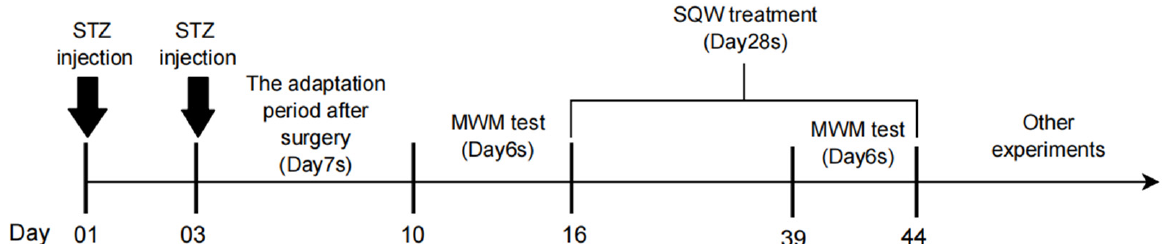
Figure 1. The schedule of animal